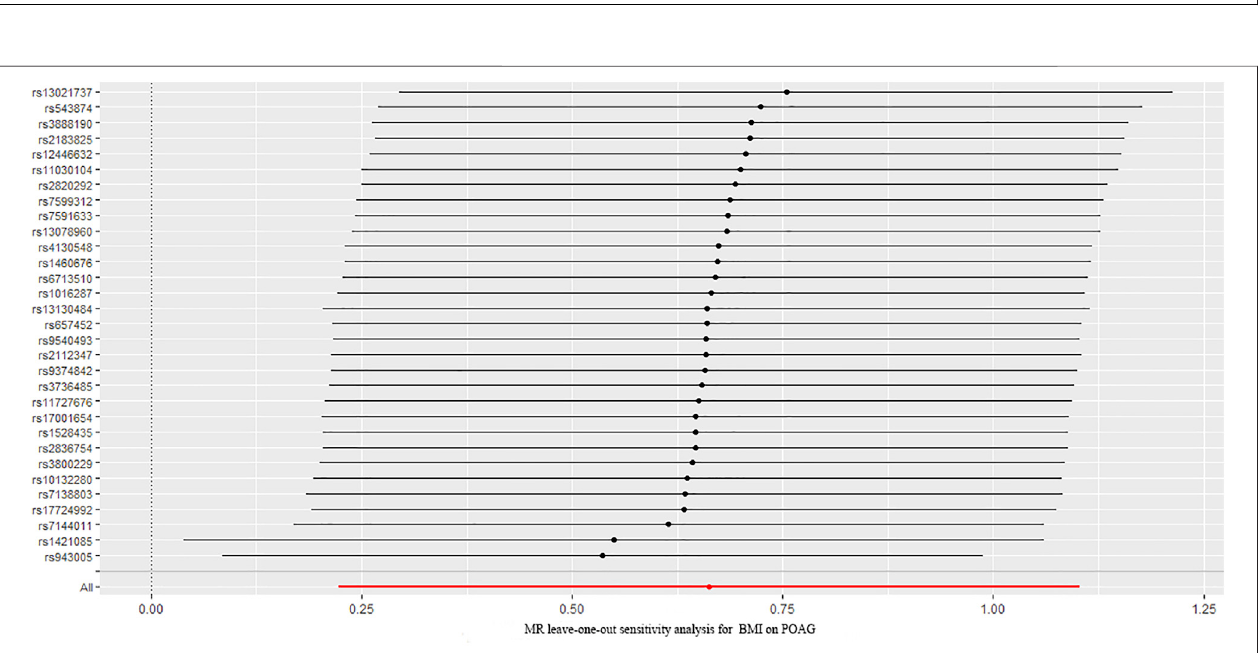
FIGURE 3 | Leave-one-out analysis plots for BMI on the risk of POAG. BMI: body mass index; POAG: primary open-angle glaucoma; MR: Mendelian randomization.